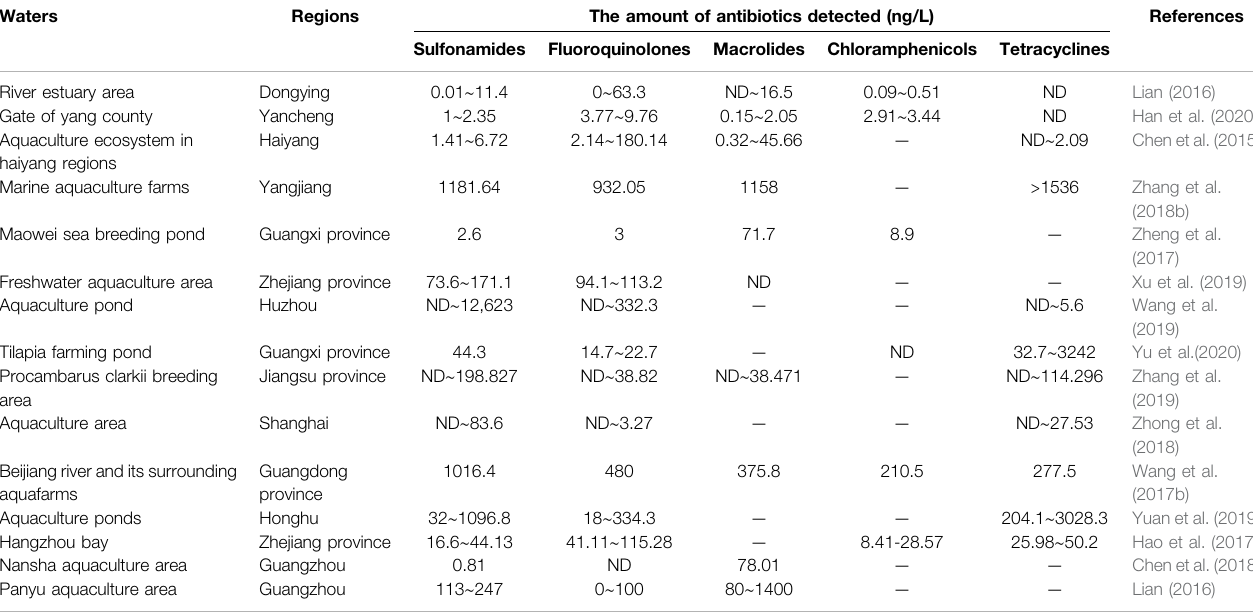
TABLE 3 | Antibiotic concentrations in surface water in aquaculture areas (From 2015 to 2020).